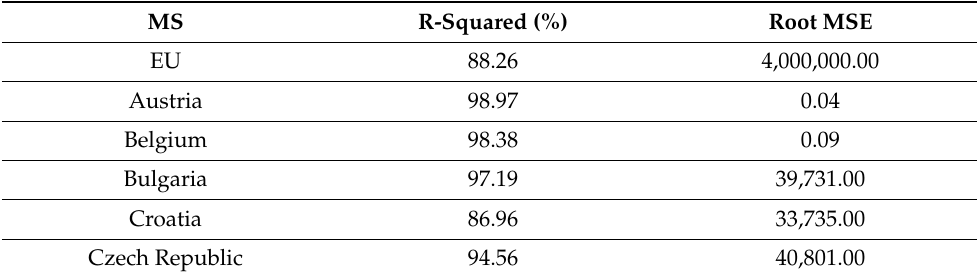
Table A1. Additional